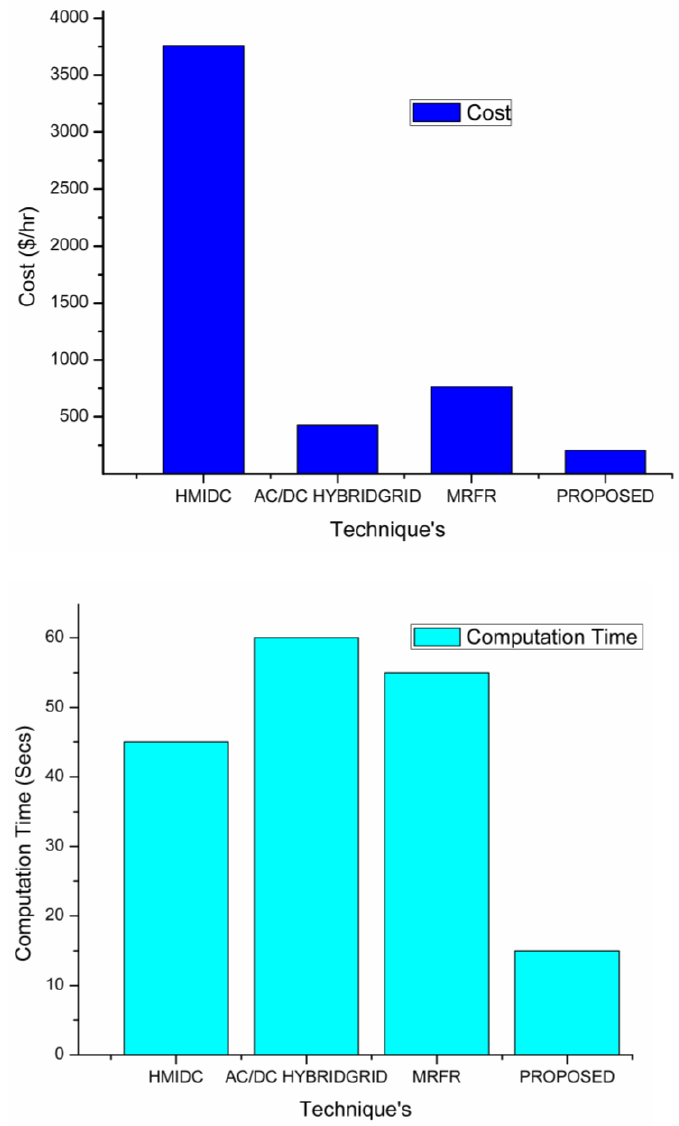
Figure 10. Comparison of computation times and costs.